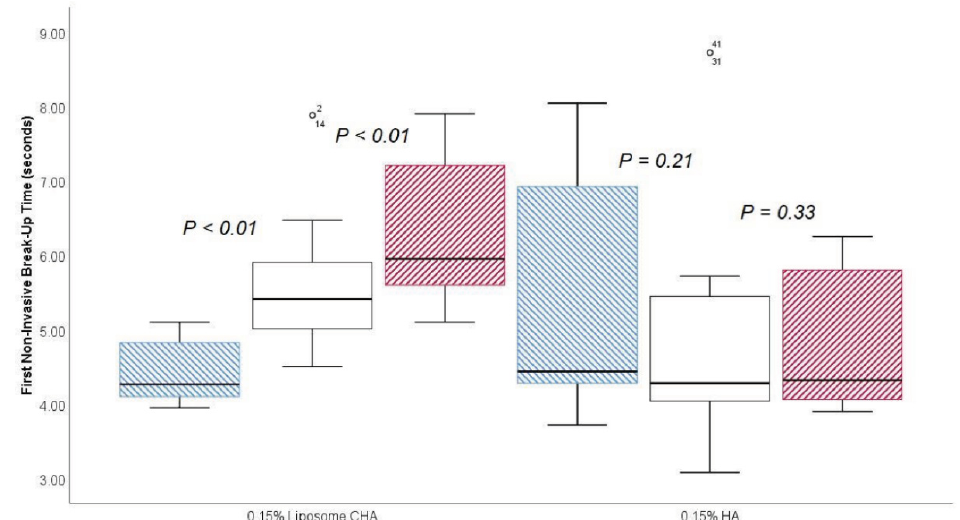
Figure 4. Box and plot of the first noninvasive break-up time between previous (blue), 30 min (white), and 45 min (red) after eyedrop instillation.